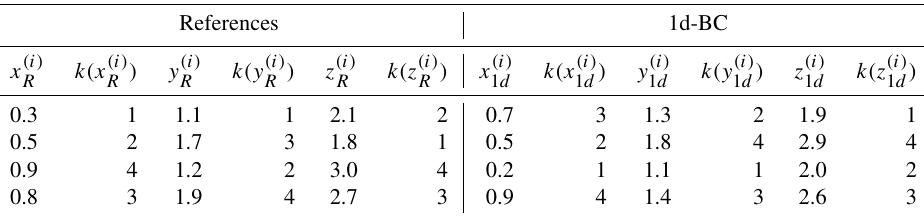
Table 1. One example of 3-dimensional reference data and results from the 1d-bias correction of sample size 4 for illustration of the R 2 D 2 method. k() indicates the rank within the sample.